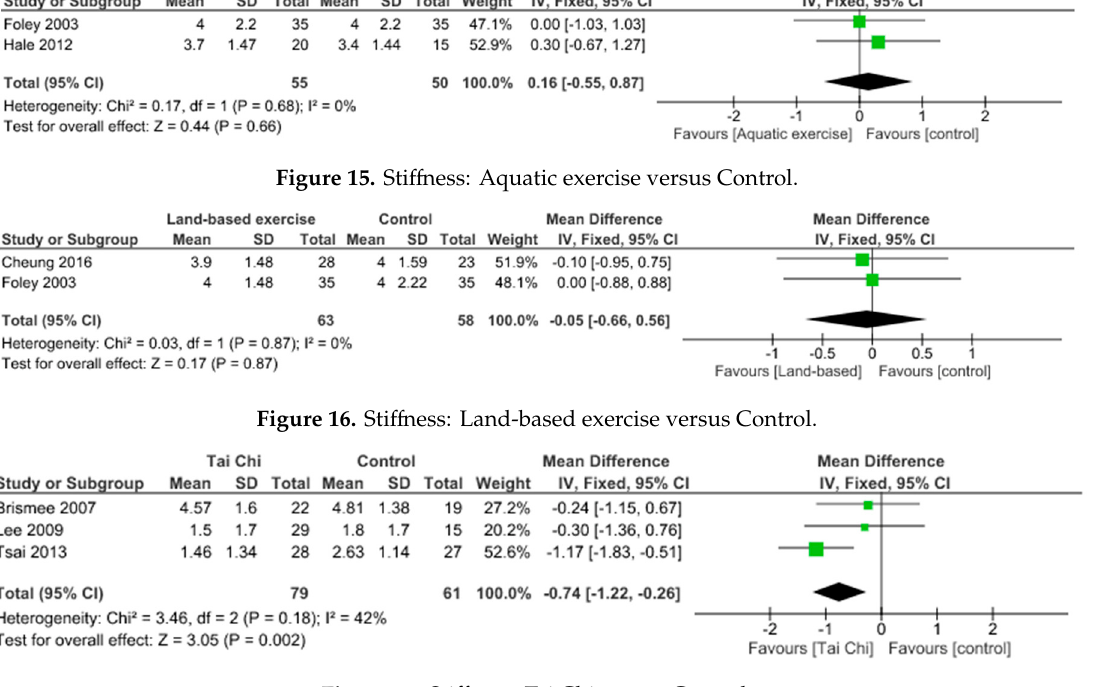
Figure 17. Sti ff ness: Tai Chi versus Control.